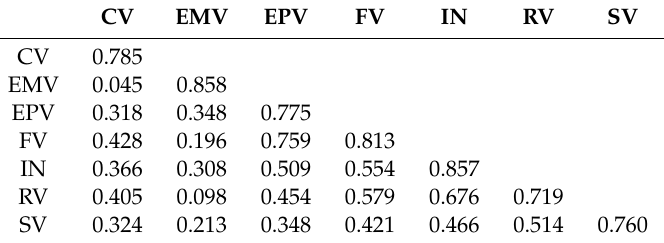
Table 4. Discriminant Validity-Fornell-Larcker Criterion.